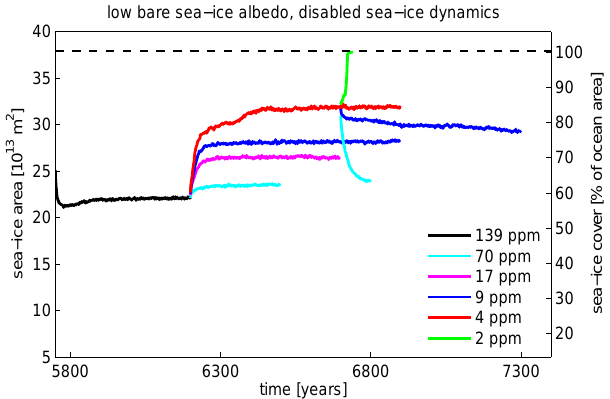
Fig. 8. Simulations with low bare sea-ice albedo and disabled sea-ice dynamics. Ocean heat transport is fully active. Evolution of annual-mean global sea-ice cover in response to an abrupt change in CO 2 from a “warm” control simulation with 139ppm CO 2 . Also shown are simulations that start from the state with 85 % sea-ice cover and apply an abrupt increase of CO 2 from 4ppm to various higher levels; these simulations search for the Jormungand bifurcation. All simulations use 94 % solar insolation.